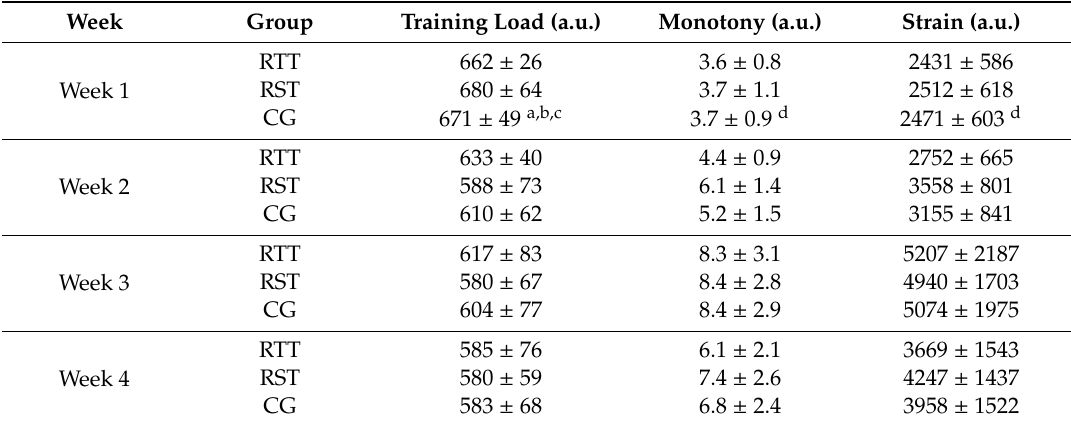
Table 1. Weekly training load, monotony and strain during the training intervention (values are mean ± SD) for RTT ( n = 12), RST ( n = 12) and CG ( n = 12). Week Group Training Load (a.u.) Monotony (a.u.) Strain (a.u.) RTT 662 ± 26 3.6 ± Week 1